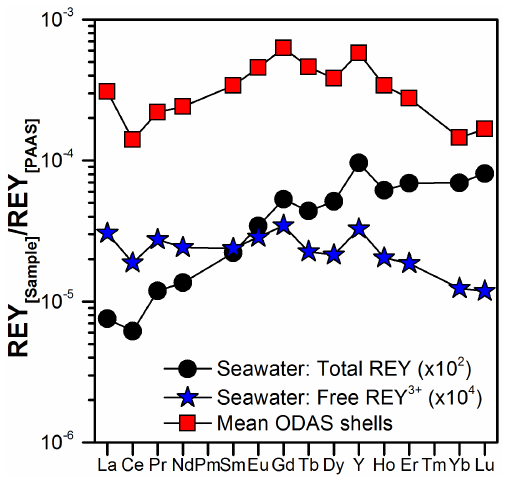
Figure 8. Total REY SN and free REY 3 + ter at the ODAS site and the average REY SN pattern of the ODAS shells.